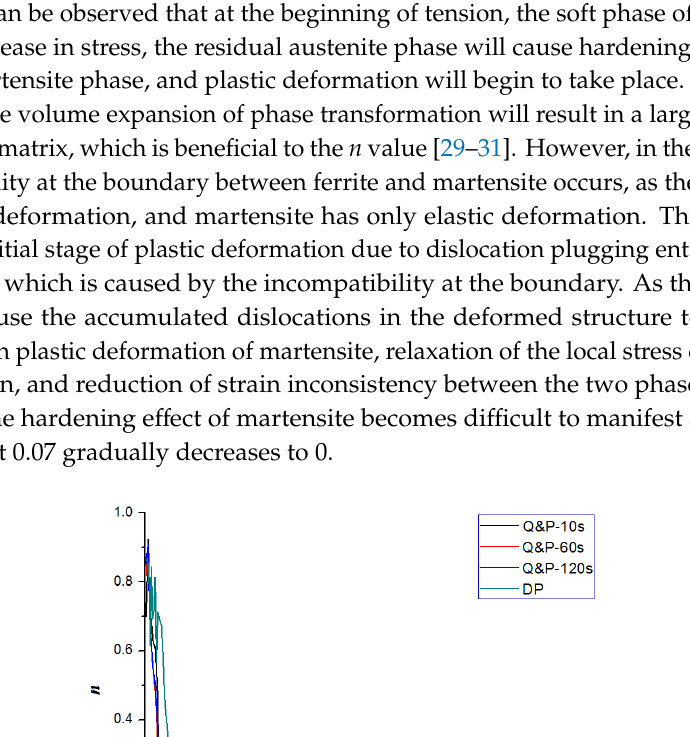
Figure 7. Relationship between n value stress–strain curves of the test steel and true strain of the test steel.